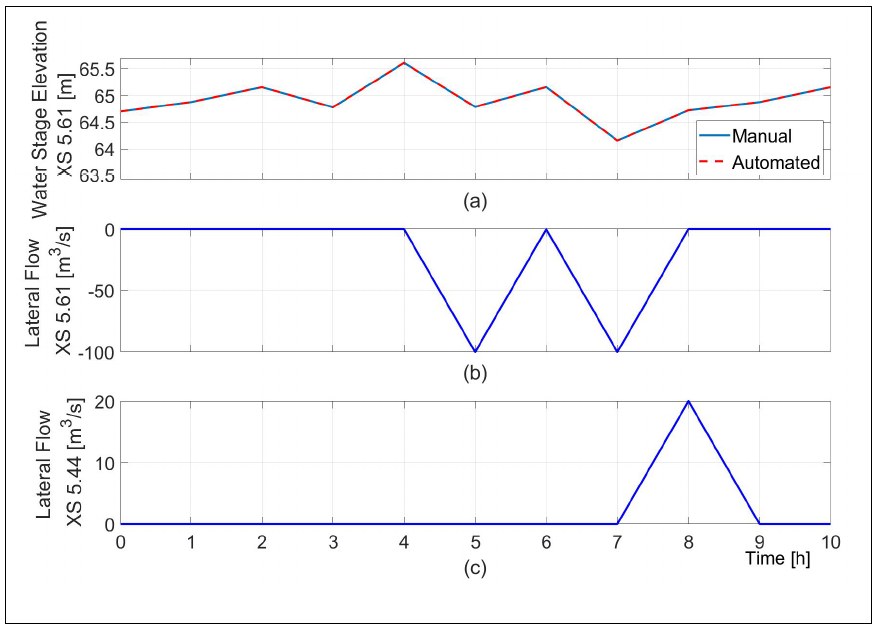
Figure 8. Beaver Creek case study— scenario3 . ( a ) WSE at XS 5.61. Lateral inflow hydrographs applied at ( b ) XS 5.61 and ( c ) XS